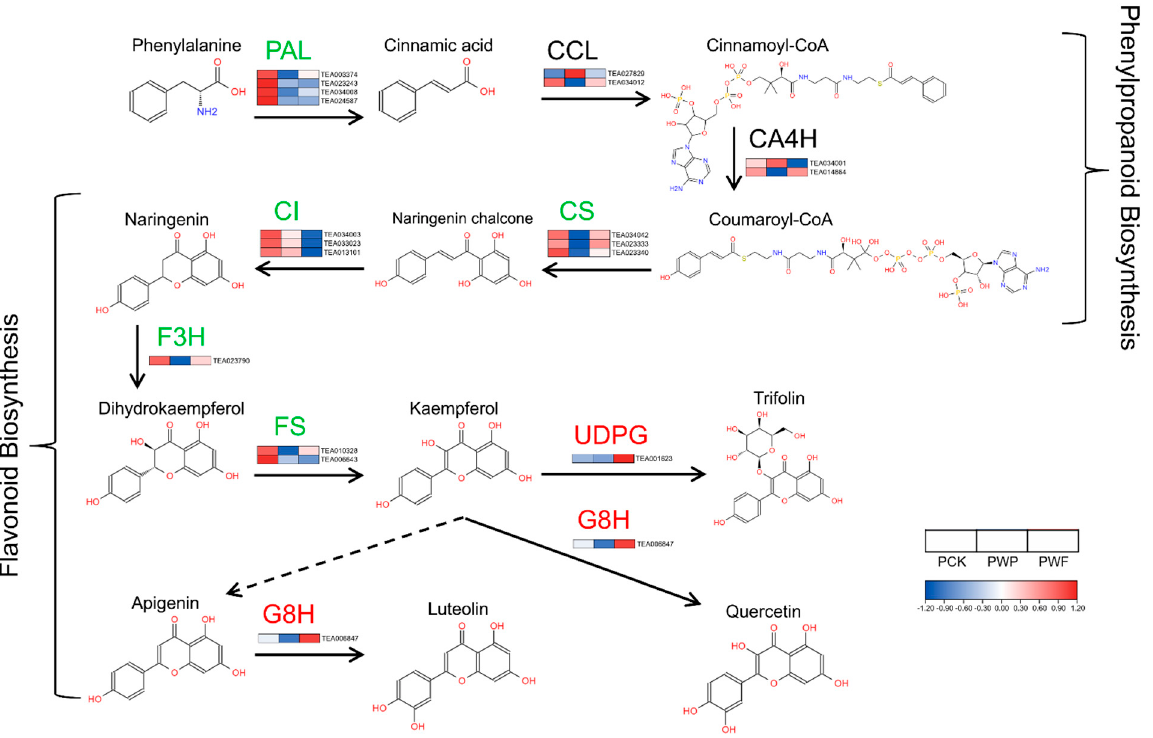
Figure 5. Effects of withering on protein expression in phenylpropanoid biosynthesis and